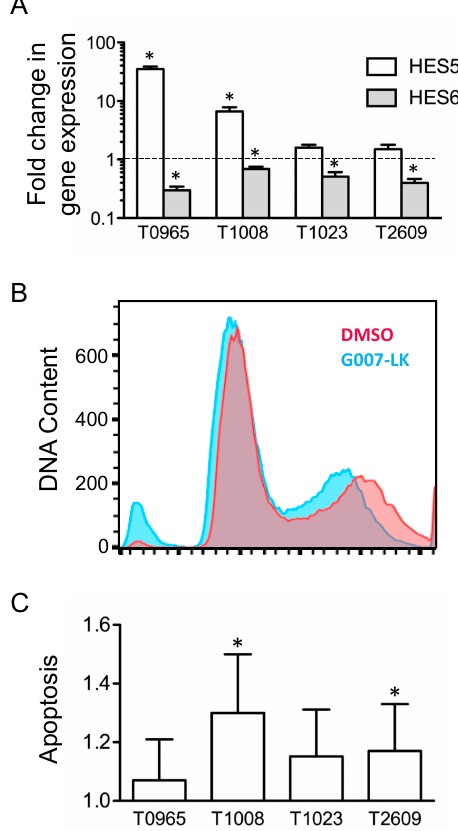
Figure 4. G007-LK alters the expression of HES transcription factors and induces apoptosis in primary GSC cultures without affecting the cell cycle. ( A ) Fold change in gene expression, as assessed by qPCR upon treatment with G007-LK (500 nM) for 72 h. Values are relative to those of the DMSO control (0.01%) and illustrated on a log10 scale. ( B ) Cell cycle histogram showing DNA content after ten days of treatment. Blue: G007-LK (500 nM); Red: DMSO control (0.01%). The Y-axis shows relative fluorescence. Data from T0965 are shown as a representative example. ( C ) Apoptosis in four GSC cultures after 48 h of treatment with G007-LK (500 nM). Values are expressed as the fold changes from the DMSO control (0.01%). The results are presented as the mean ± SD. * p < 0.05.